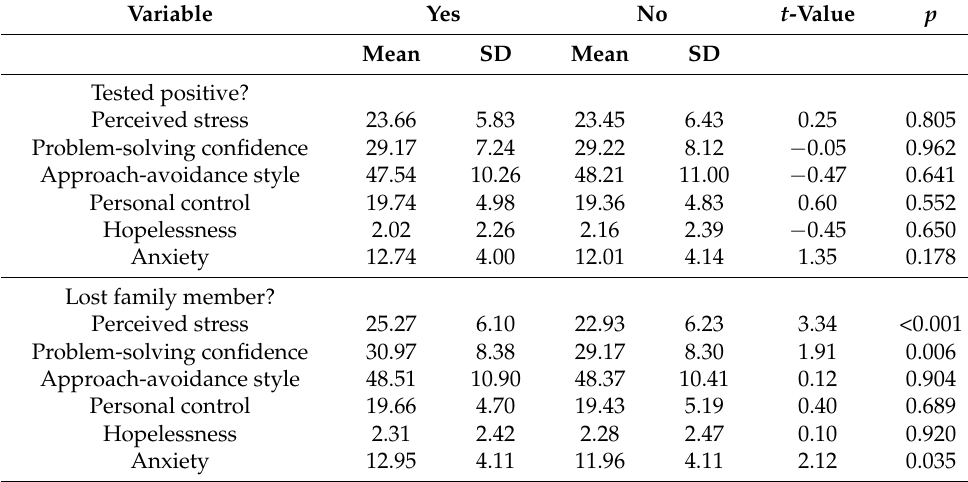
Table 2. Comparison of those who had tested positive for COVID-19 or those who lost a family member with those who had not tested positive or lost a family member.